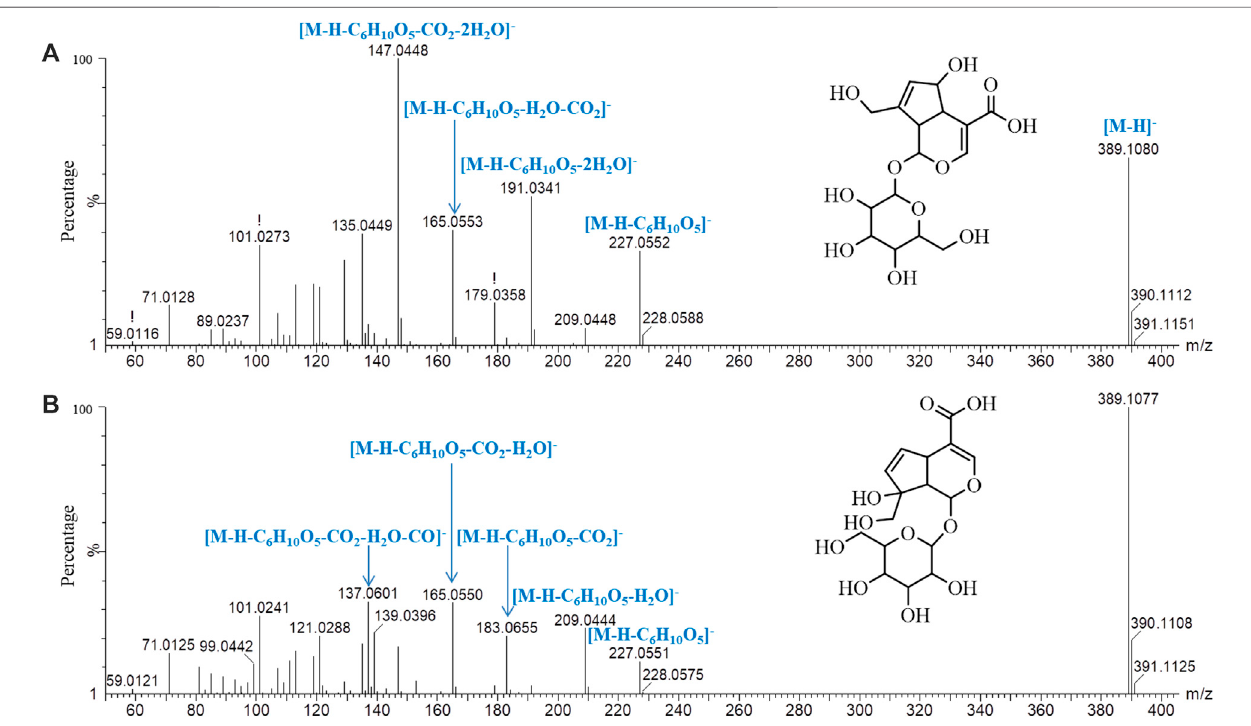
Frontiers in Chemistry |